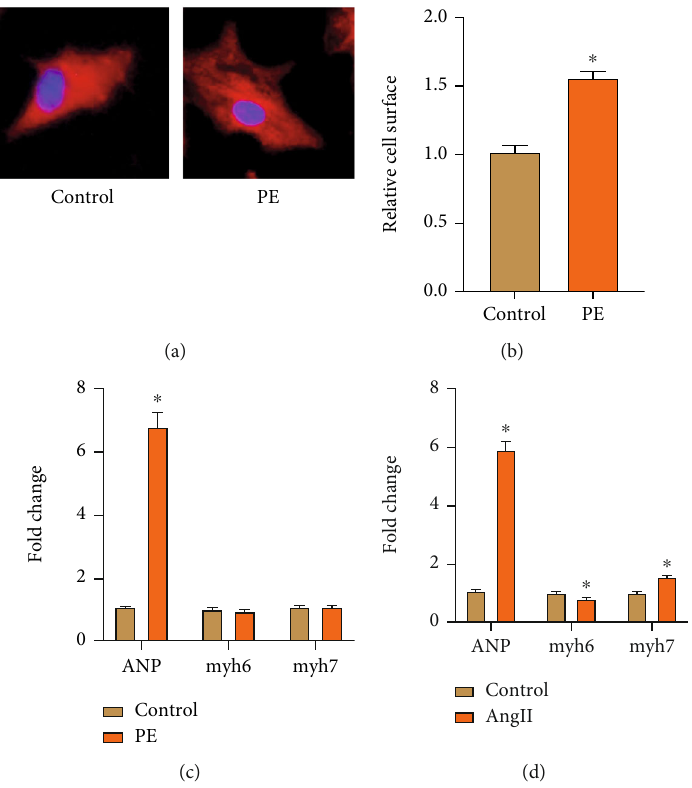
Figure 2: Identi fi cation of primary MH model. (a) Cell immuno fl uorescence staining α -actinin in control and PE groups. (b) Analysis of cardiomyocyte surface area ( “ ∗ ” indicates statistical di ff erence from the control group P < 0 : 05 ). (c) The expression of ANP, myh6, and myh7 in the control and PE groups ( “ ∗ ” indicates statistical di ff erence from the control group P < 0 : 05 ). (d) The expression of ANP, myh6, and myh7 in the control and Ang II groups ( “ ∗ ” indicates statistical di ff erence from the control group P < 0 : 05